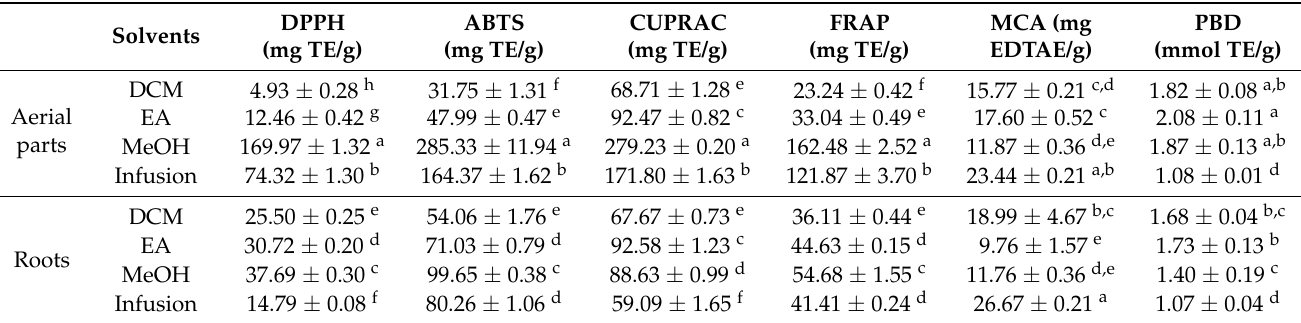
Table 6. Antioxidant properties of Sartoria hedysaroides extracts